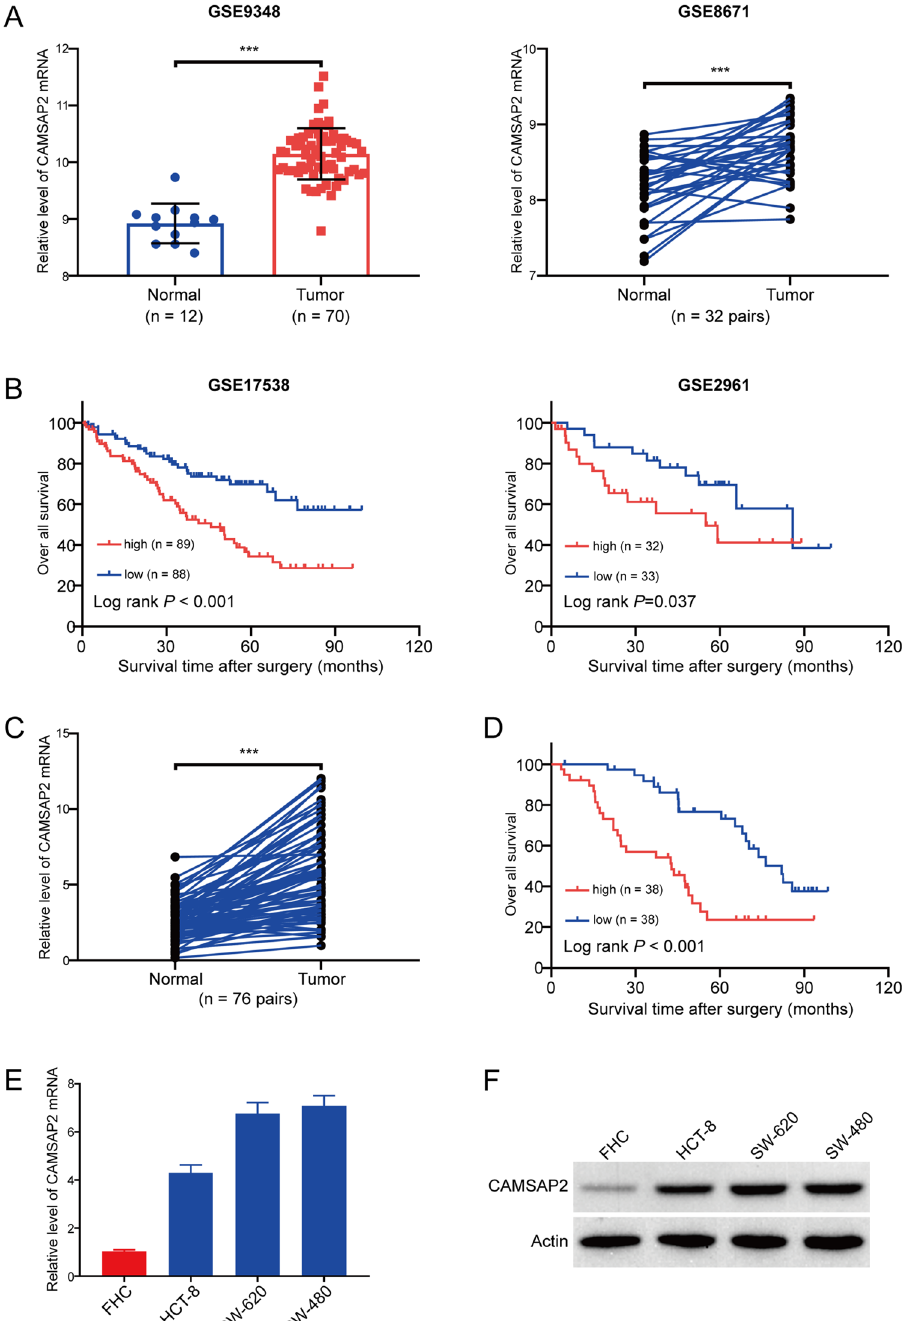
Figure 1. CAMSAP2 was highly expressed in colorectal cancer and is associated with poor prognosis. ( A ) The mRNA level of CAMSAP2 in GSE9348 (left panel) and GSE8671 (right panel) cohorts. ( B ) Influence of CAMSAP2 expression on overall survival by Kaplan–Meier analysis in GSE17538 (n = 177) and GSE2961 (n = 65) cohorts. ( C ) qRT-PCR analysis of CAMSAP2 mRNA in 76 pairs of colorectal cancer and the adjacent normal tissues. ( D ) Kaplan–Meier survival analysis of colorectal cancer patients’ overall survival based on the mRNA level of CAMSAP2 in our cohort (n = 76). ( E ) The mRNA expression of CAMSAP2 in colorectal cancer cells (HCT-8, SW-620 and SW-480) and FHC cells was detected by using qRT-PCR analysis. (F) Western blot analysis of CAMSAP2 protein in FHC and colorectal cancer cell lines. *** P <